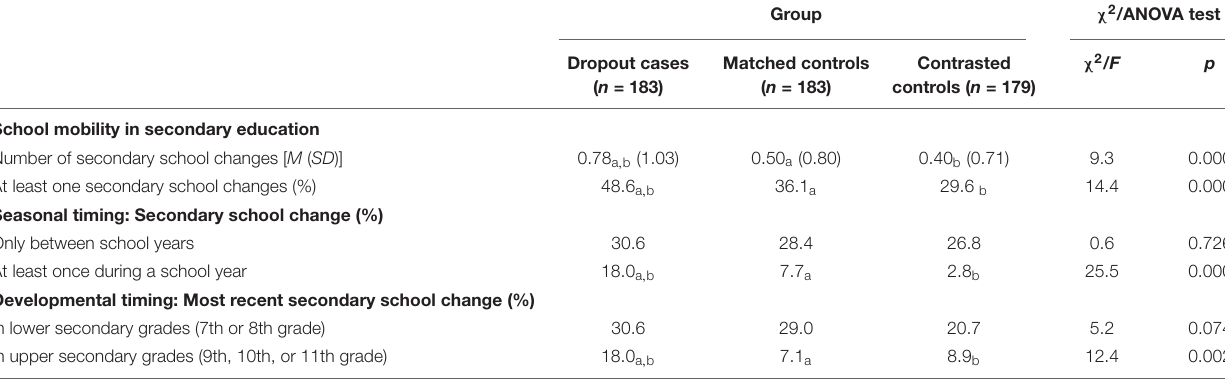
TABLE 2 | School mobility as a function of group membership.